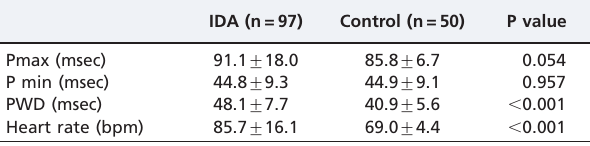
Table 2 - Comparison of P wave variables and heart rate for iron-deficient anemic patients versus healthy